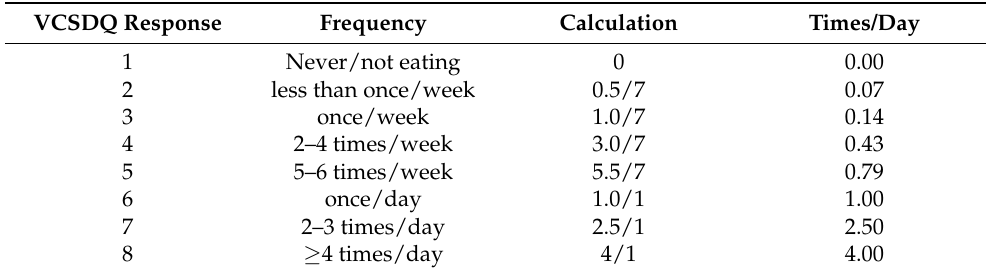
Table 1. Conversion table compilated based on the calculation from